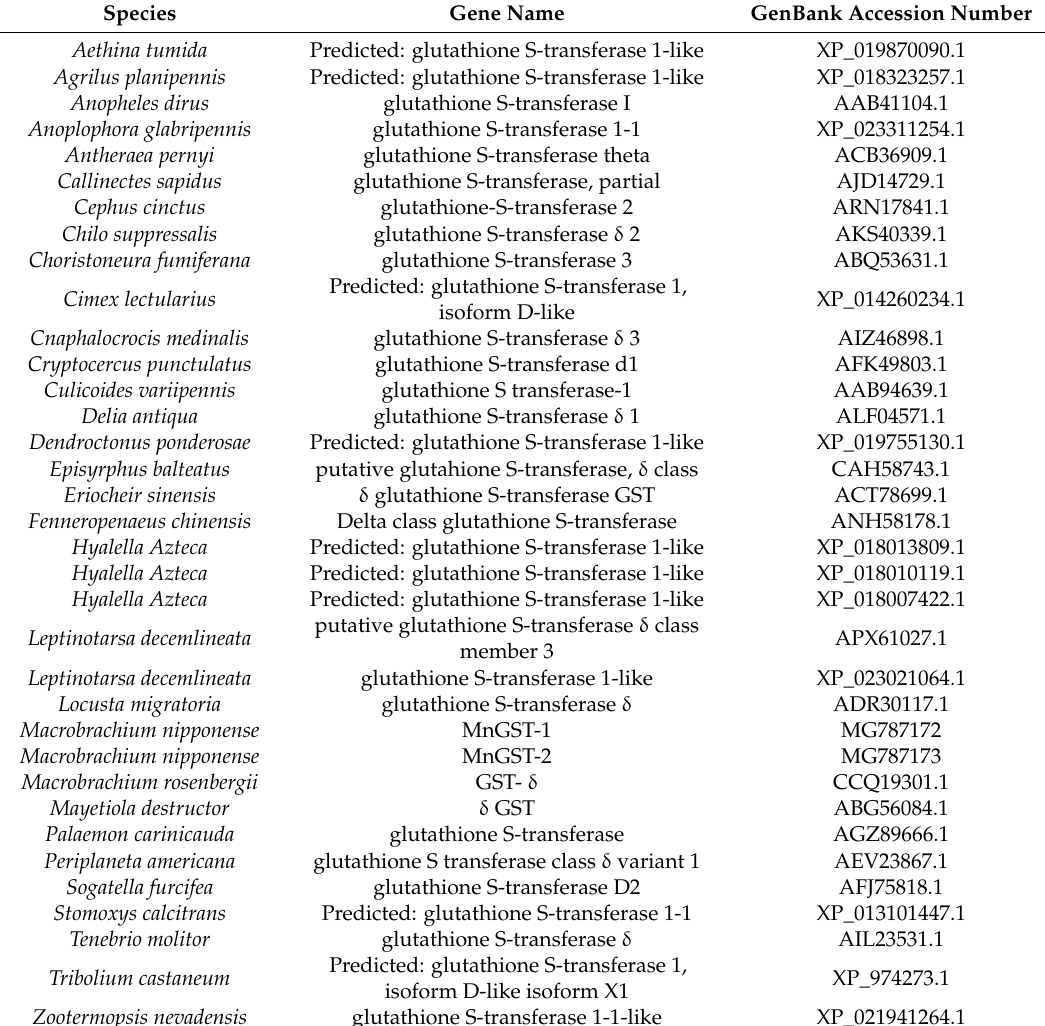
Table 2. Mature peptide sequences of glutathione S-transferase (GST) family